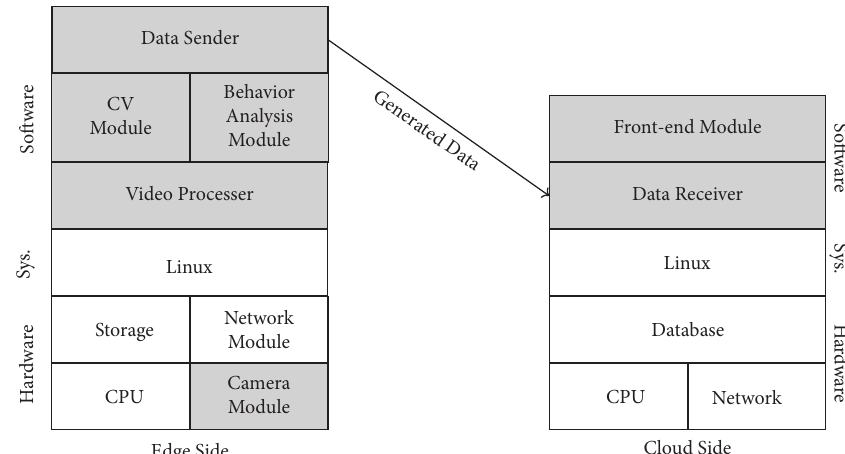
Figure 1: System architecture (Masked parts are main module of eaCamera).